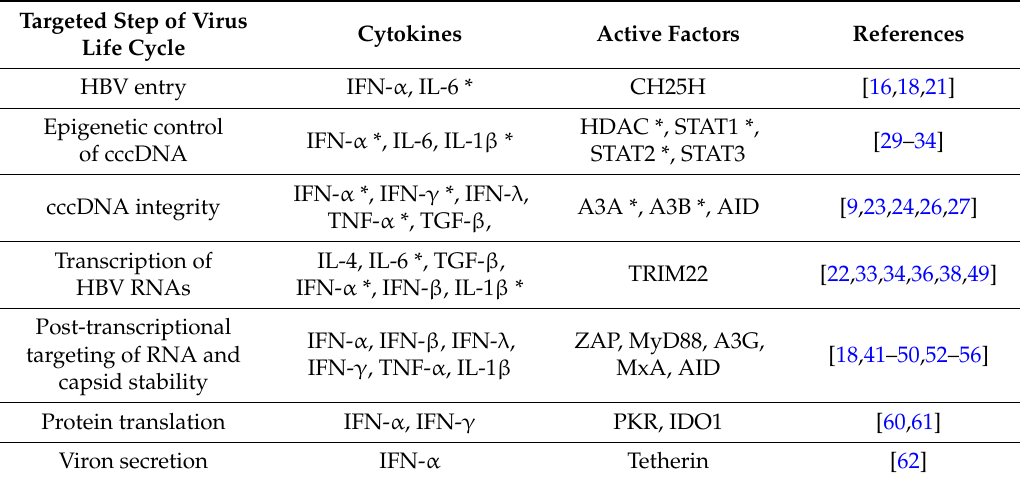
Table 1. Control of hepatitis B virus (HBV) by